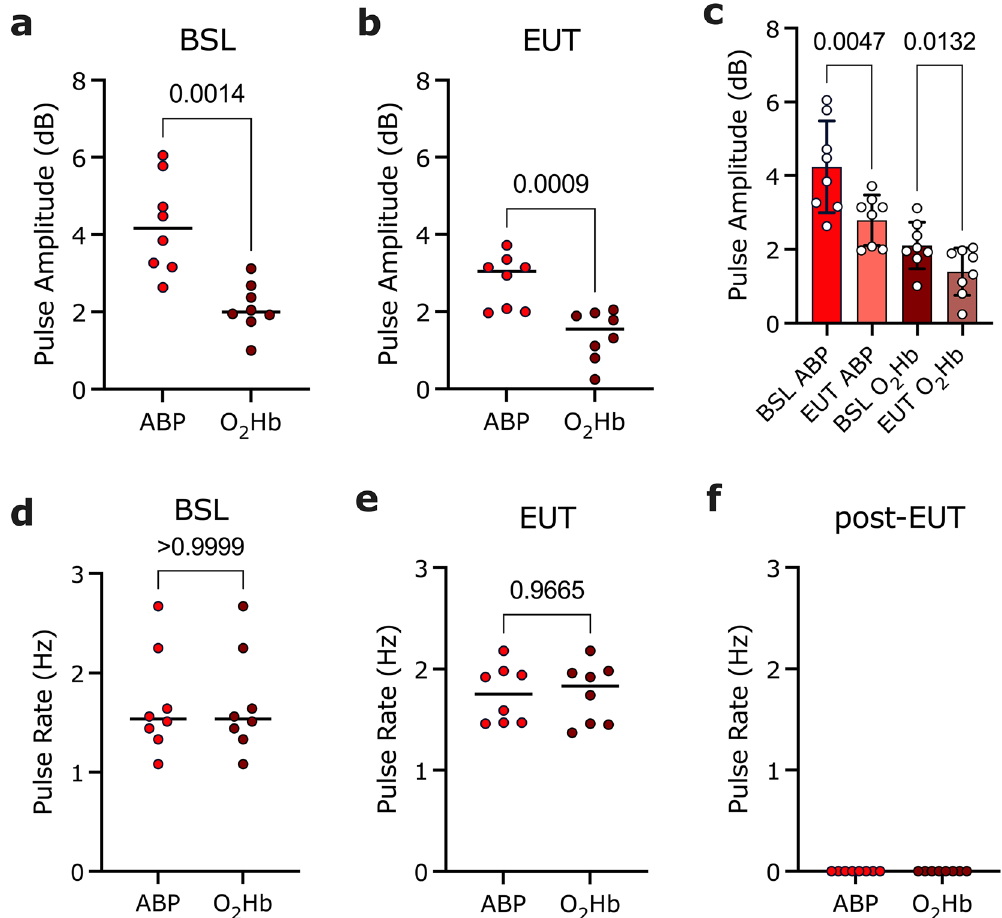
Figure 6. Comparison of ABP and NIRS-derived pulse rate and amplitude changes in response to pentobarbital administration. Mean ABP and O 2 Hb-derived pulse amplitudes (dB) (n = 8) during ( a ) baseline ( p = 0.0014) and ( b ) euthanasia ( p = 0.0009) (Student’s t -test, level of significance p < 0.05). ( c ) ABP and O 2 Hb pulse amplitudes (dB) at BSL vs EUT (Repeated measure ANOVA, adjusted p-values: ABP BSL vs EUT p = 0.0047 and O 2 Hb BSL vs EUT p = 0.0132; level of significance p < 0.05). Mean ABP and O 2 Hb-derived pulse rates (Hz) (n = 8) during ( d ) baseline ( p > 0.99), ( e ) euthanasia ( p = 0.97) and ( f ) post-euthanasia (unable to calculate p ).